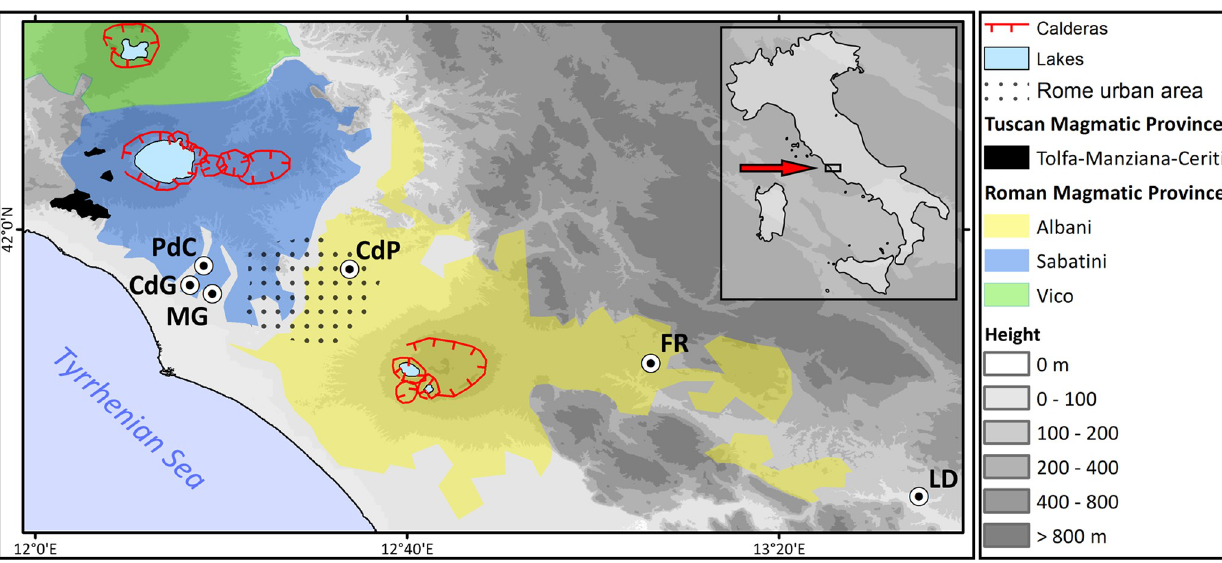
Fig 1. Location of sites mentioned in the text and in Table 1. CdG = Castel di Guido, MG = Malagrotta, PdC = Polledrara di Cecanibbio, CdP = Casal de’ Pazzi, FR = Fontana Ranuccio, LD = Lademagne. The Roman Magmatic Province [4, 5] is formed by large volcanic complexes, namely the Colli Albani, the Monti Sabatini, the Vico volcano and the Monti Volsini to the north (the last not shown on this map). Drawing by G. Boschian. Figure sources: Roman Magmatic Province outcrops simplified from Carta geologica informatizzata Regione Lazio 1: 25000, doi.org/10.13140/2.1.2667.8080 (available under Creative Commons Attribution 4.0 - CC BY 4.0) with updates from GB fieldwork. Topographic background from USGS Shuttle Radar Topography Mission (Courtesy of NASA/Jet Propulsion Laboratory Caltech; credit line requested by JPL policy).